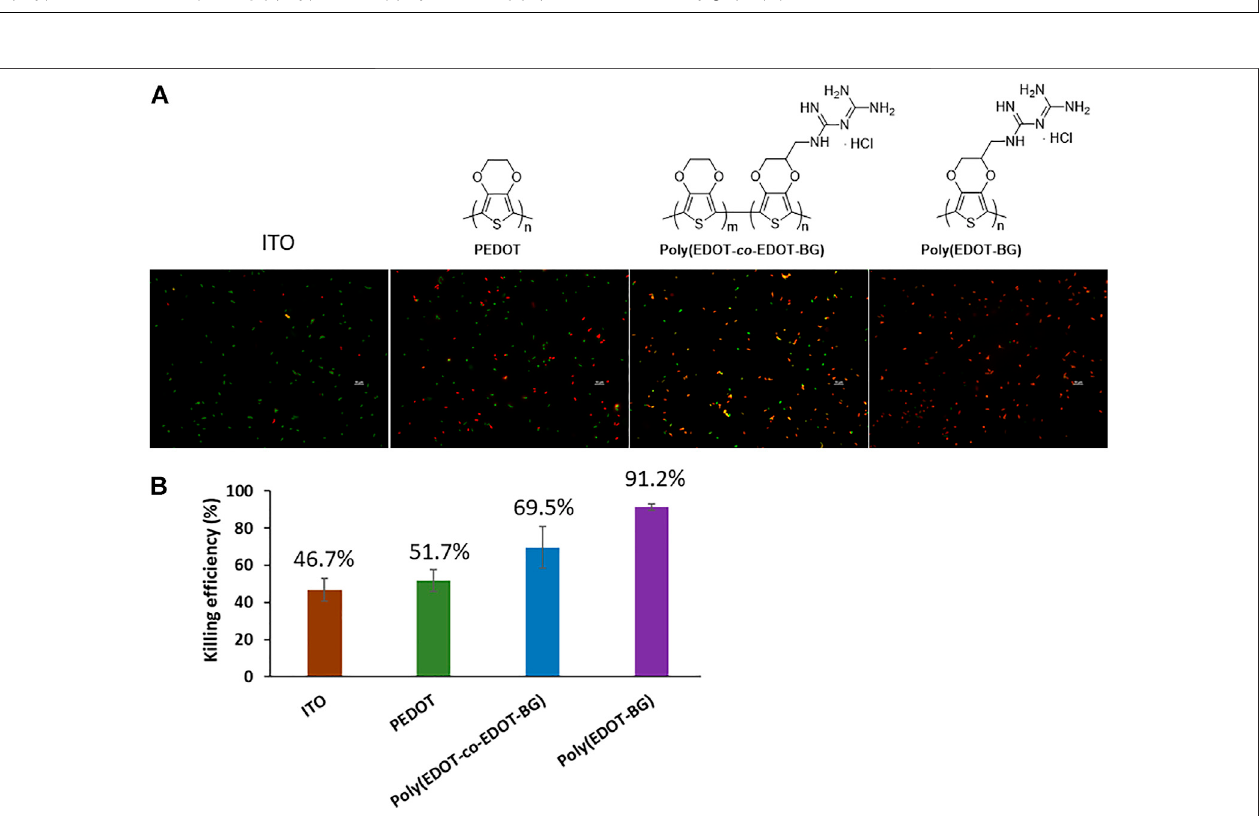
Frontiers in Chemistry |